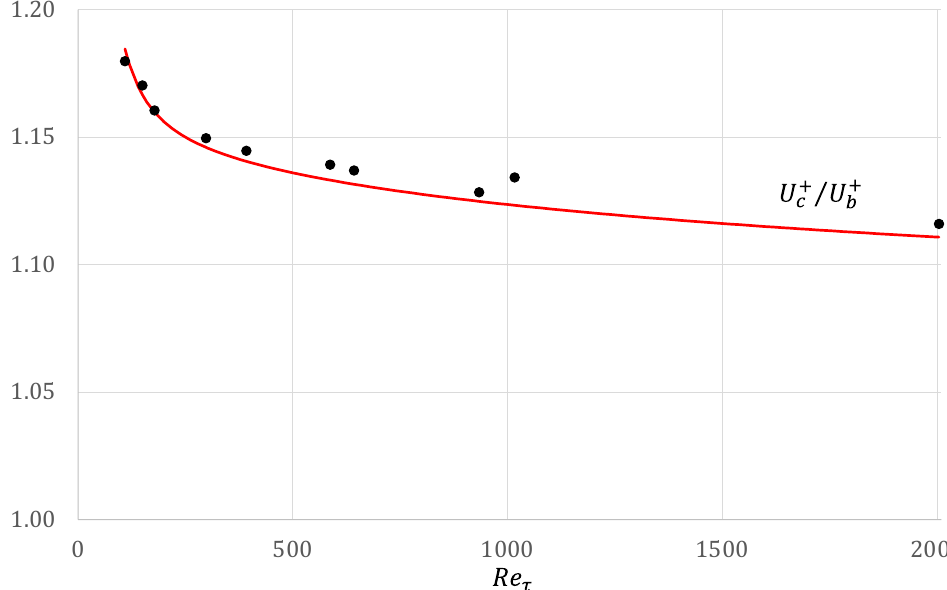
Figure 3. Trend of the ratio U c + / U b + ; • DNS data; and –